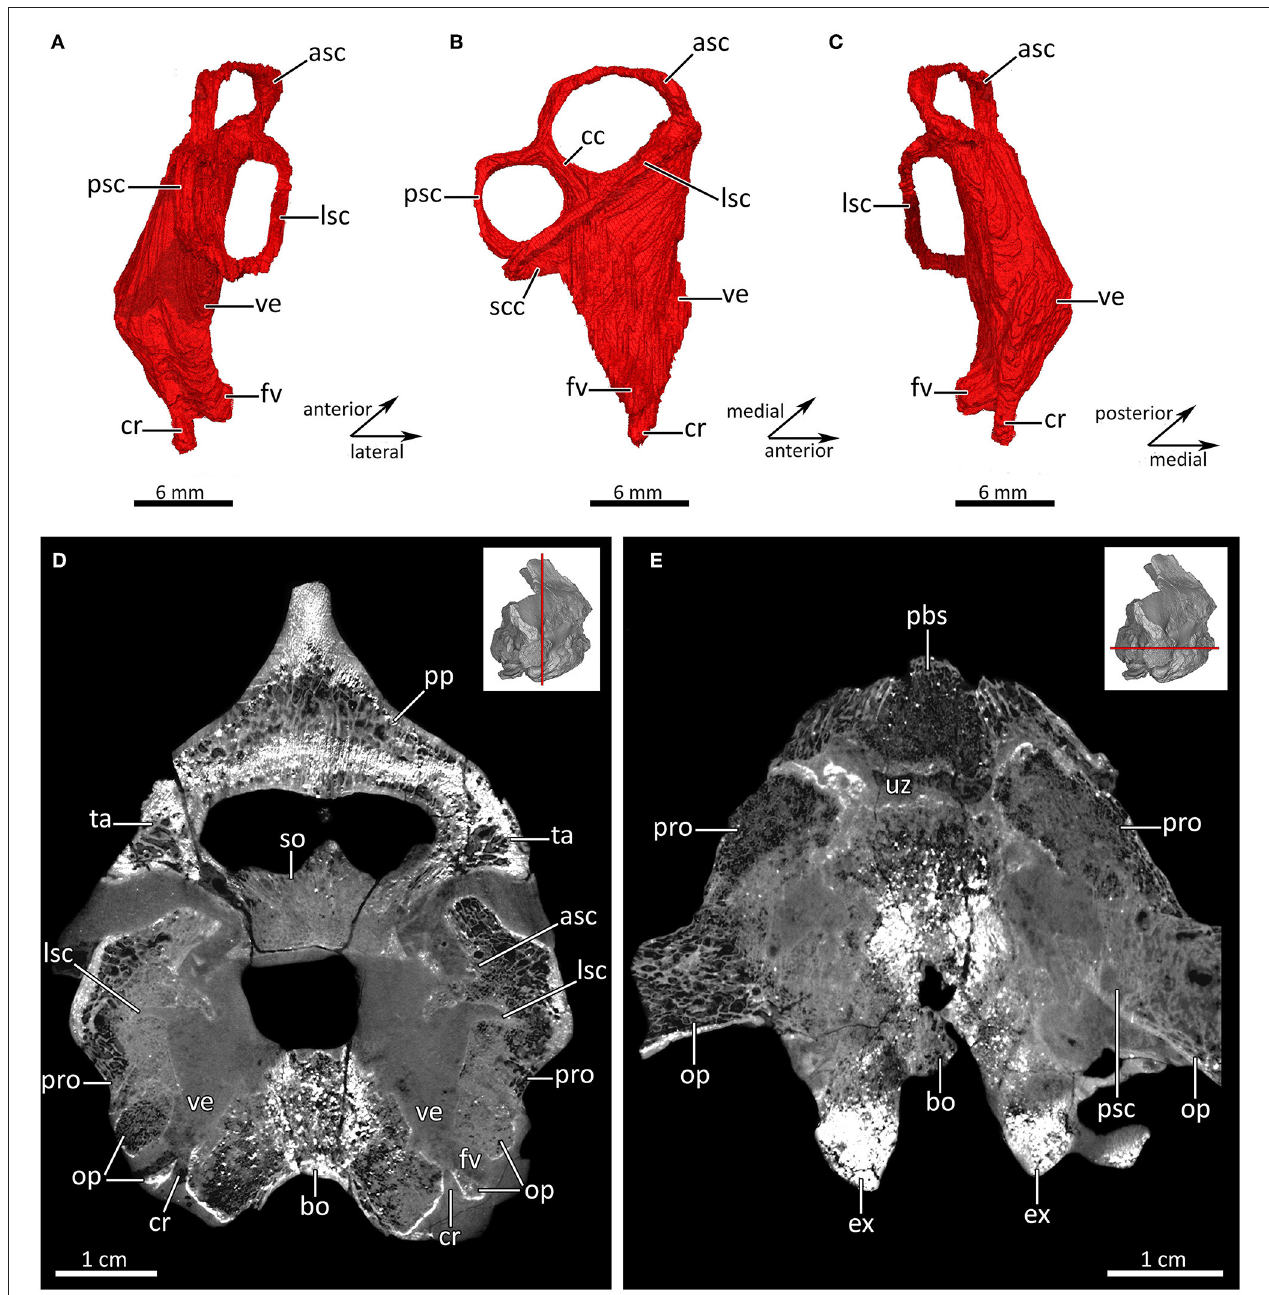
FIGURE 11 | The inner ear labyrinth of MB.R.995. Virtual cast of the right inner ear labyrinth in (A) posterior, (B) lateral, and (C) anterior views. (D) Transverse and (E) horizontal CT section through the otic region. asc, anterior semicircular canal; bo, basioccipital; cc, crus commune; cr, cochlear recess; ex, exoccipital; fv, fenestra vestibuli; lsc, lateral semicircular canal; op, opisthotic; pbs, parabasisphenoid; pp, postparietal; pro, prootic; psc, posterior semicircular canal; scc, secondary crus commune; so, supraoccipital; ta, tabular; uz, unossified zone; ve, vestibule. The opisthotic consists of a robust paroccipital process, view, forming the ventral border of the foramen magnum which is crushed on both sides. The right paroccipital process ( Figures 10B–D ). The ventral surface of the basioccipital is lacks much of its lateral portion, while the left one is more slightly damaged. It is concave medially but becomes convex complete but is marked by a large crack and lacks part of laterally, with a process that slightly curves around the its ventral portion. The lateral margin of the left opisthotic is ventromedial margin of the opisthotic and contributes to the concave and lies in a medially facing fossa of the medial border of the cochlear recess ( Figures 10B–D,F , 11D ).